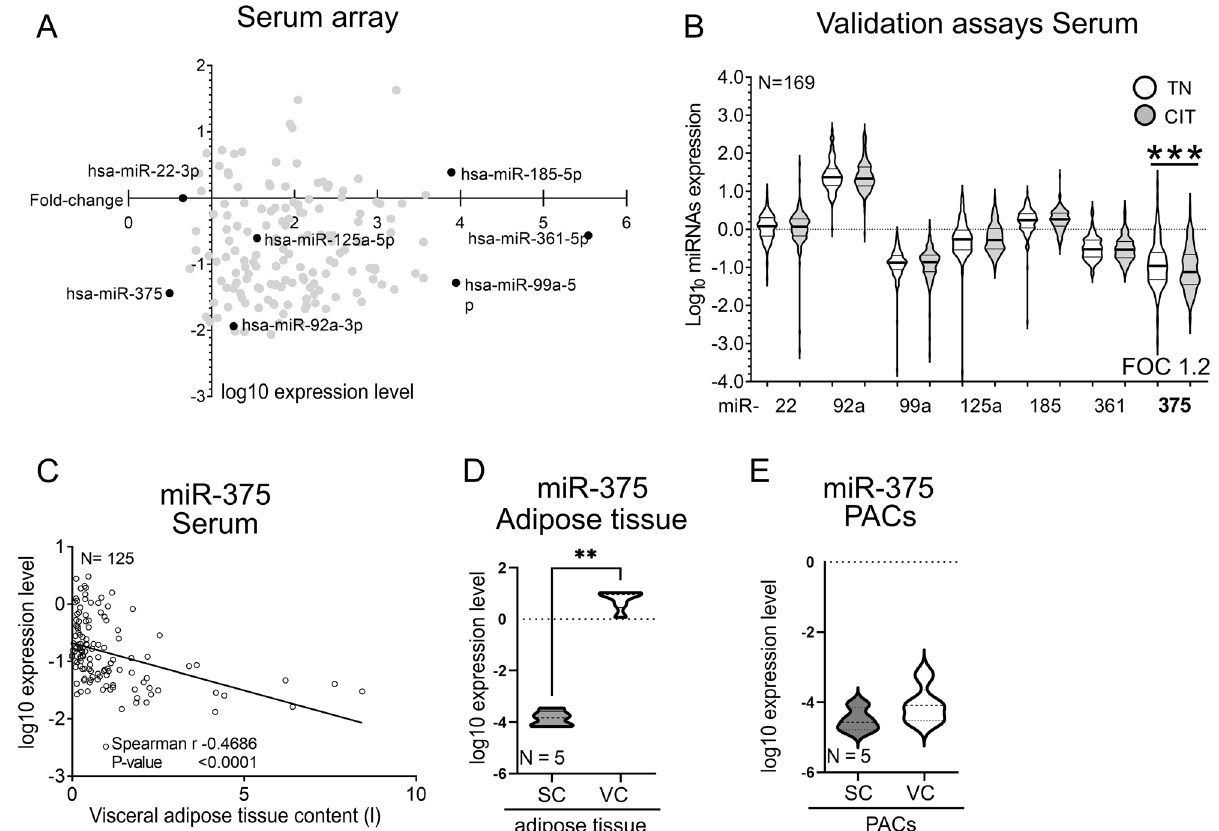
Figure 1. miRNA expression pattern in serum of healthy humans after acute cold exposure is visceral tissue associated. ( A ) Scatter plot analysis between logarithmic expression levels (C q ) and fold-change of miRNAs after cold exposure measured via microarray. miRNAs chosen for validation analysis are labeled in black. ( B ) Serum samples analysis of 169 individuals undergoing cold exposure revealed significant downregulation of miR-375 (Wilcoxon signed-rank test, one-tailed, P ≤ 0.0001 ). ( C ) Correlation of TN miR-375 levels with visceral adipose tissue content (Spearman r = − 0.469, P ≤ 0.0001 ). ( D, E ) miR-375 expression levels in VC tissue and isolated pre- adipocytes in comparison to SC ones (Mann Whitney, one-tailed, P = 0.0022 ). Data are normalized for relevant housekeeping genes, age and BMI adjusted, log 10 transformed and shown as mean ± SEM. CIT = cold induced non-shivering thermogenesis, SC = subcutaneous, VC = visceral, TN =